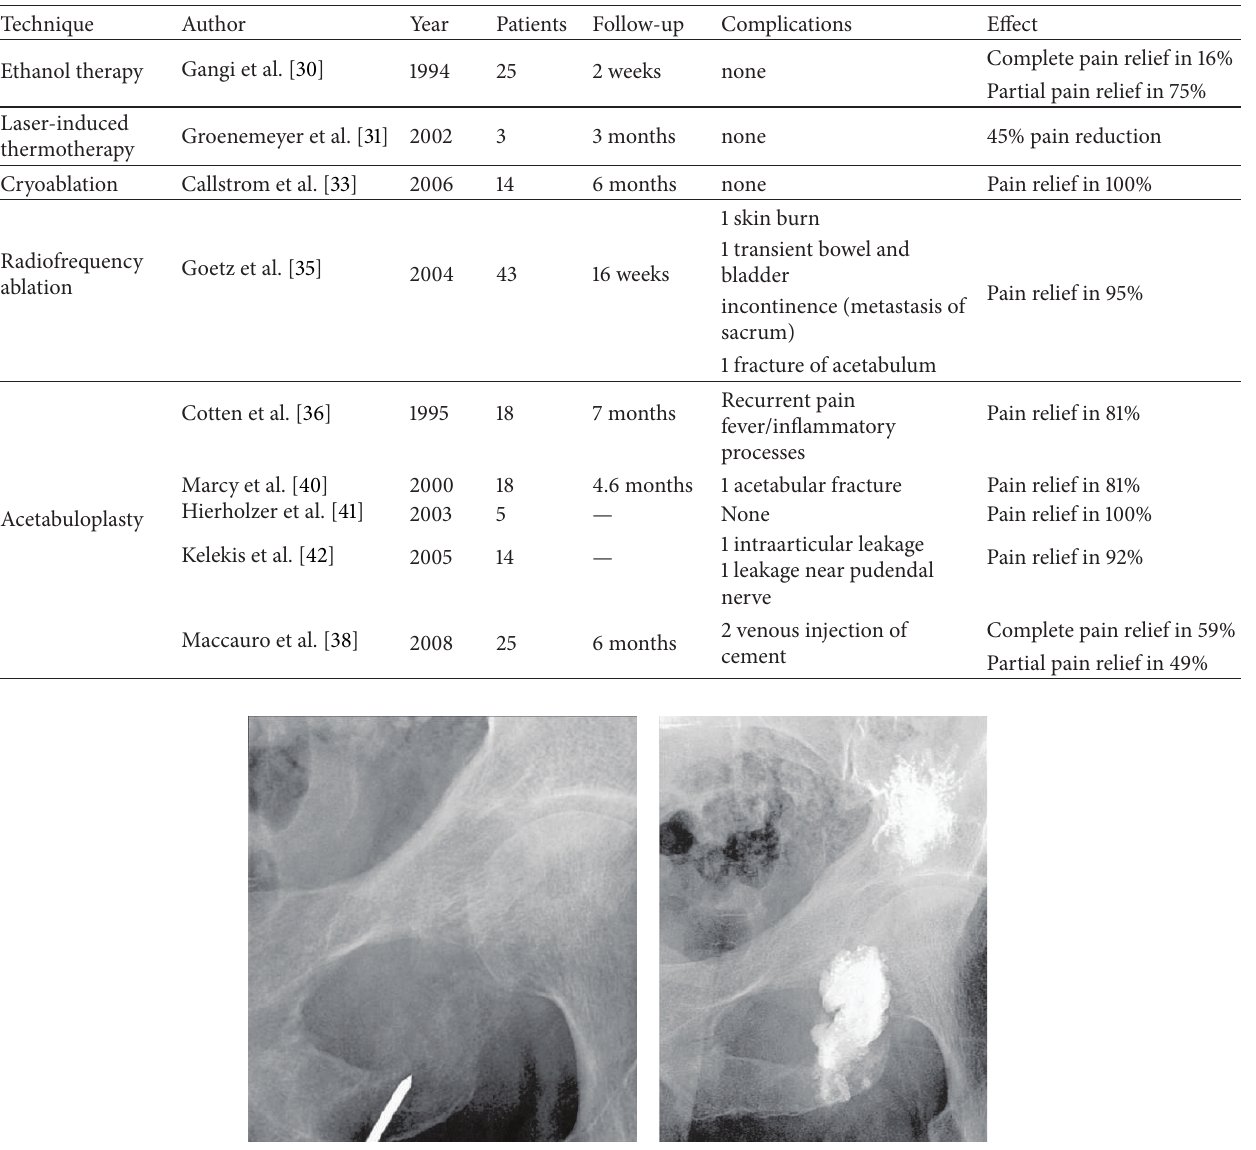
Figure 7: Intra- and postoperative radiographies of an